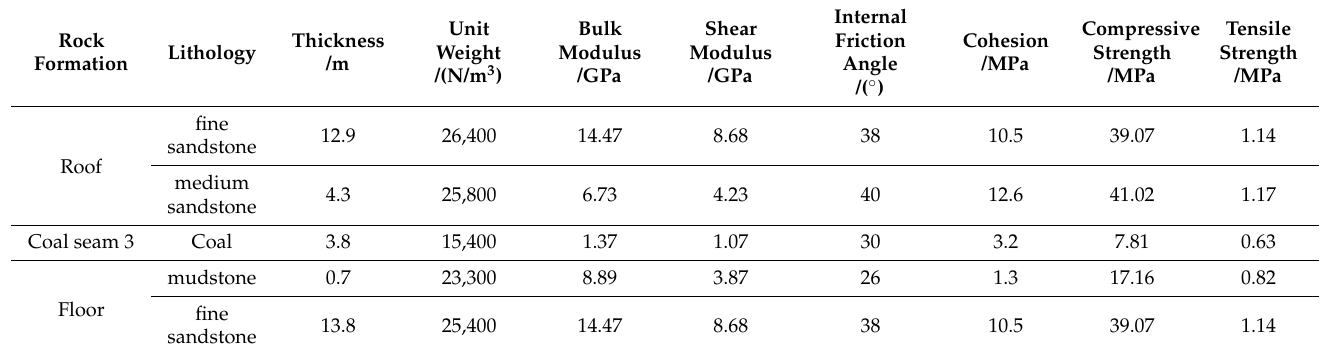
Table 3. Mechanical parameters of coal and rock mass required for